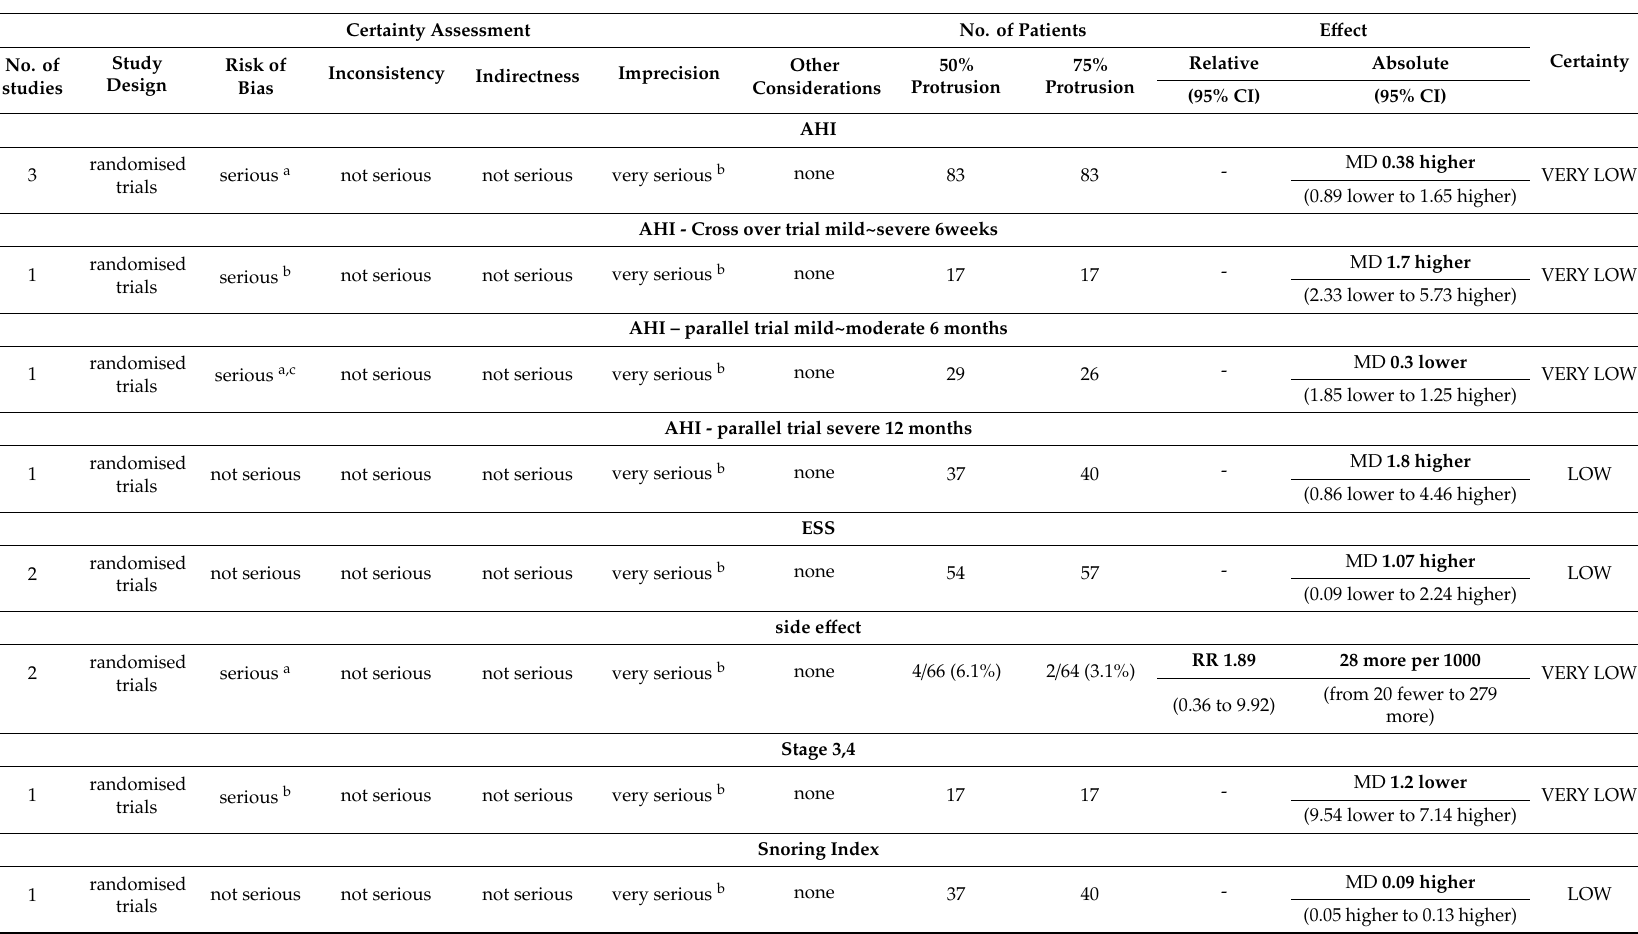
Table 2. Assessment of quality using the Grading of Recommendations, Assessment, Development, and Evaluation (GRADE) system for comparison of the studies. Certainty Assessment No. of Patients E ff ect CertaintyNo. of studies